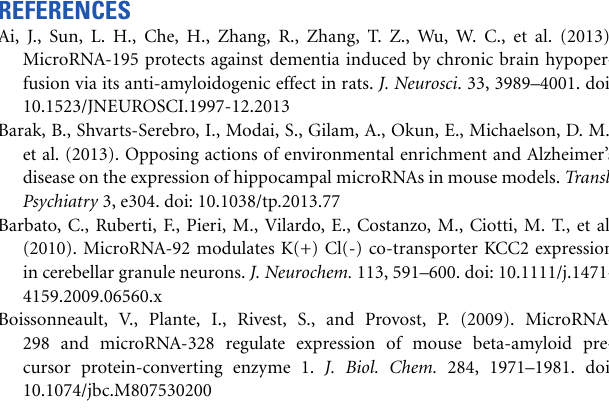
Figure S1 | The gel blot of RanBP9 protein level in three independent hippocampal cultured neurons expressing the miR-101 sponge construct (pLSyn-miR-101 sponge) and the parental control vector (pLSyn). Two exposure time of RanBP9 are shown. Figure S2 | Reduction of RanBP9 protein levels by miR-101 overexpression. (A) Western immunoblots show the expression of RanBP9 and APP in hippocampal neurons that were transduced with either a control lentiviral vector (pLB-scr) expressing a control microRNA or a lentiviral vector expressing a mature miR-101 (pLB-101) (B) GAPDH-relative expressions are shown in the histogram. Data are presented as the means ± the SD ( ∗ p < 0 . 05; ∗∗ p < 0 . 01, Student’s t -test; n =